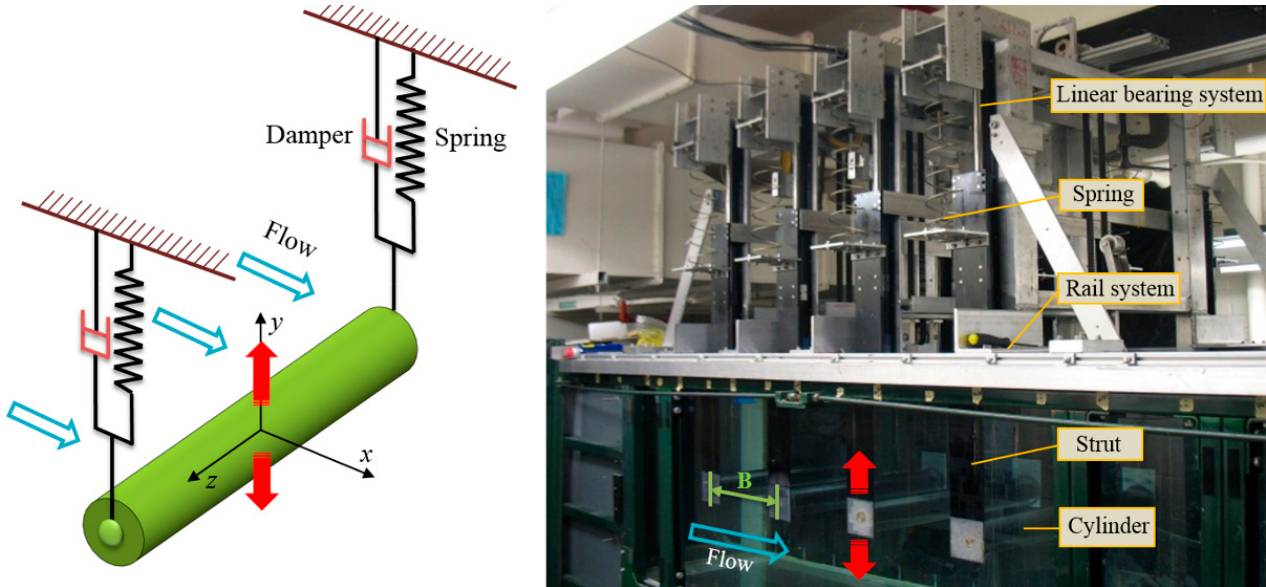
Figure 2. (Left) Simple schematic of the VIVACE module with coordinate system; (Right) four new VIVACE converters mounted on the LTFSW channel [10,11].